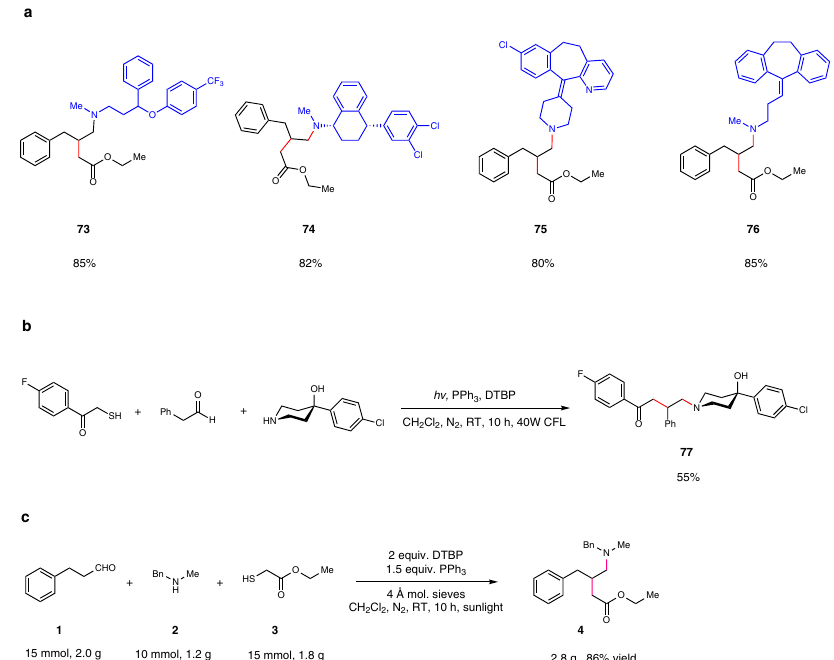
Fig. 4 Synthetic utilities of the radical homo Mannich reaction. a Late-stage modi fi cation of pharmaceutical agents. b Synthesis of the analog of Haloperidol. c Scale-up reaction for compound 4 under the sunlight.